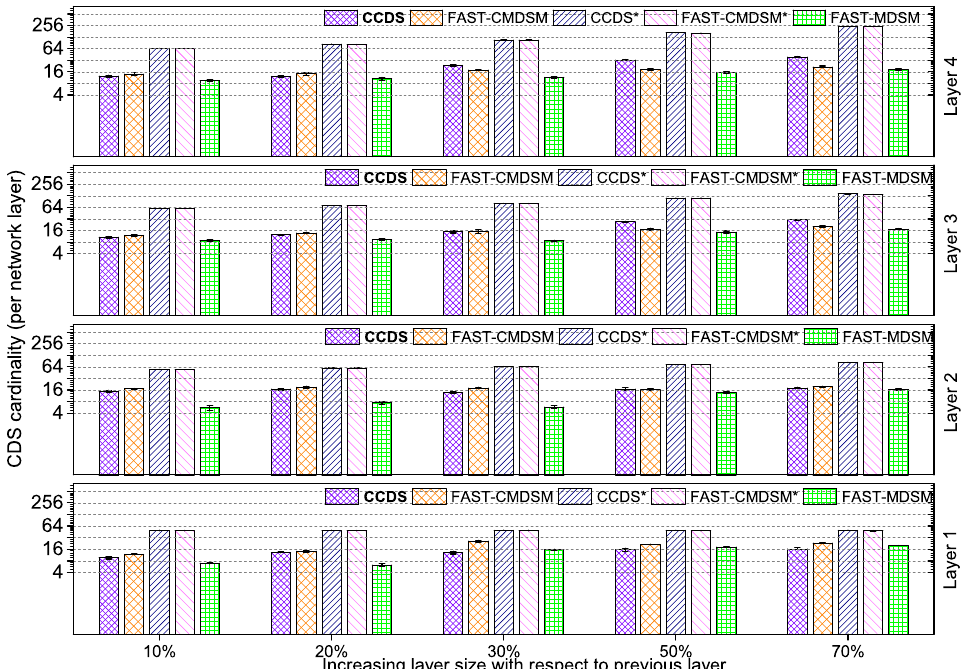
Figure 14. Impact of increasing layer cardinality (Medium skewness).